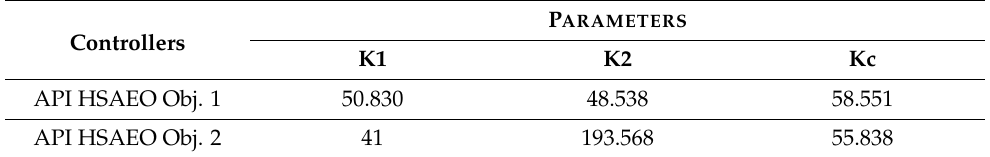
Table 10. Controller parameters used in faulty operation cases.